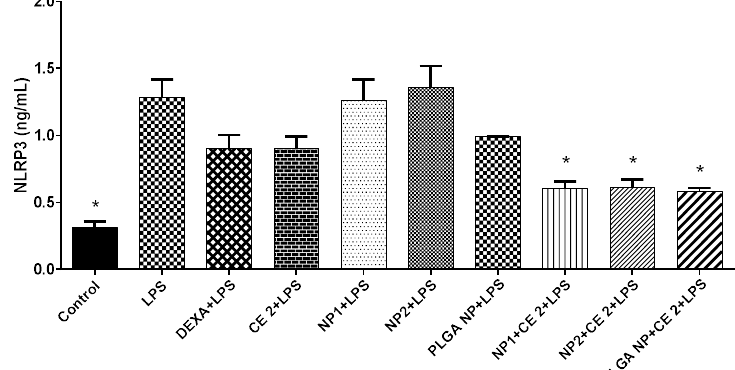
Figure 5. NLRP3 inflammasome activation. HUVEC were treated with empty or CE-loaded NPs (NP1:QA-Ch-NP; NP2:QA-Ch-S-pro-NP; and PLGA NP) with 2 µg/mL GAE of CE (CE 2) or DEXA (5 µg/mL) for 2 h and with LPS (10 µg/mL) for 24 h. Data are expressed as means ± SD of at least three independent experiments in triplicate. * p < 0.05 vs. LPS.